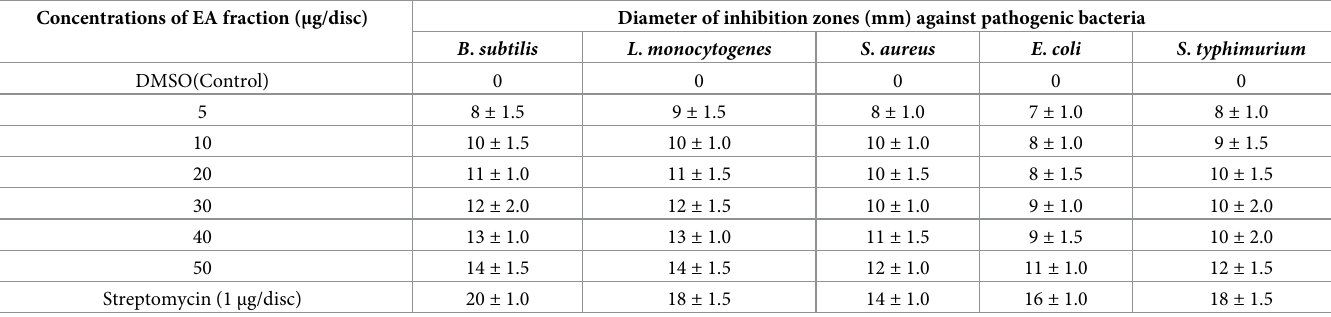
Table 1. Antibacterial activity of ethyl acetate extract of AE1 by disc diffusion method. Concentrations of EA fraction ( μ g/disc) Diameter of inhibition zones (mm) against pathogenic